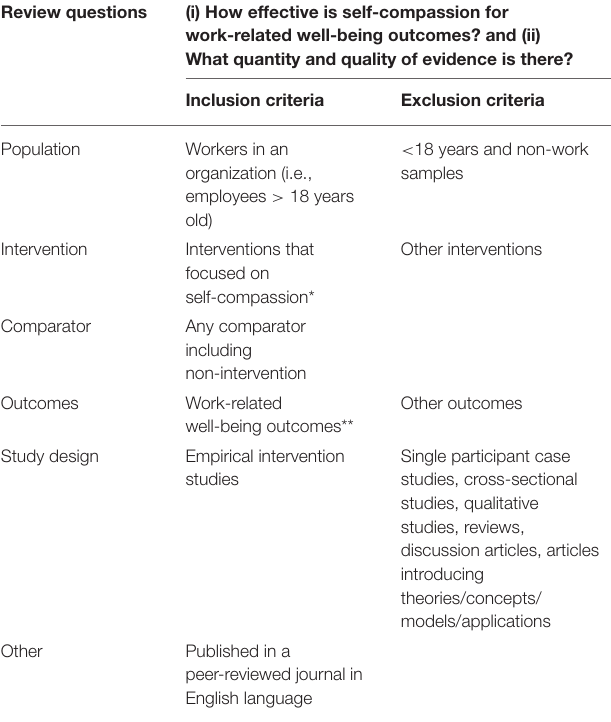
TABLE 1 | Extended PICO for this systematic